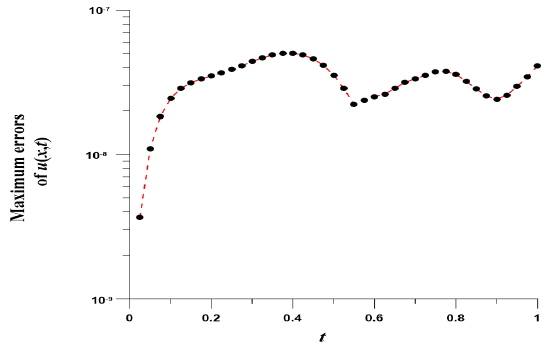
Figure 6. For Example 3: ME( u ) versus t in the time interval.